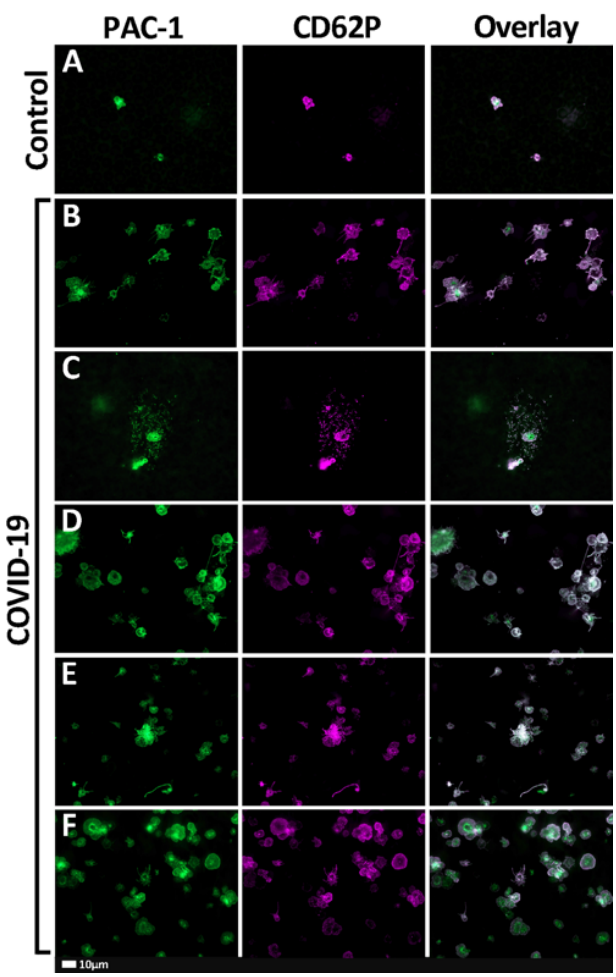
Figure 1. ( A – F ) Representative fluorescent micrographs of whole-blood samples stained with PAC-1 (green fluorescence) and CD62P-PE (purple fluorescence). The last column represents an overlay of the two micrographs. ( A ) Representative healthy (control) platelets. ( B – F ) Representative fluorescent micrographs from coronavirus disease 2019 (COVID-19) patients.